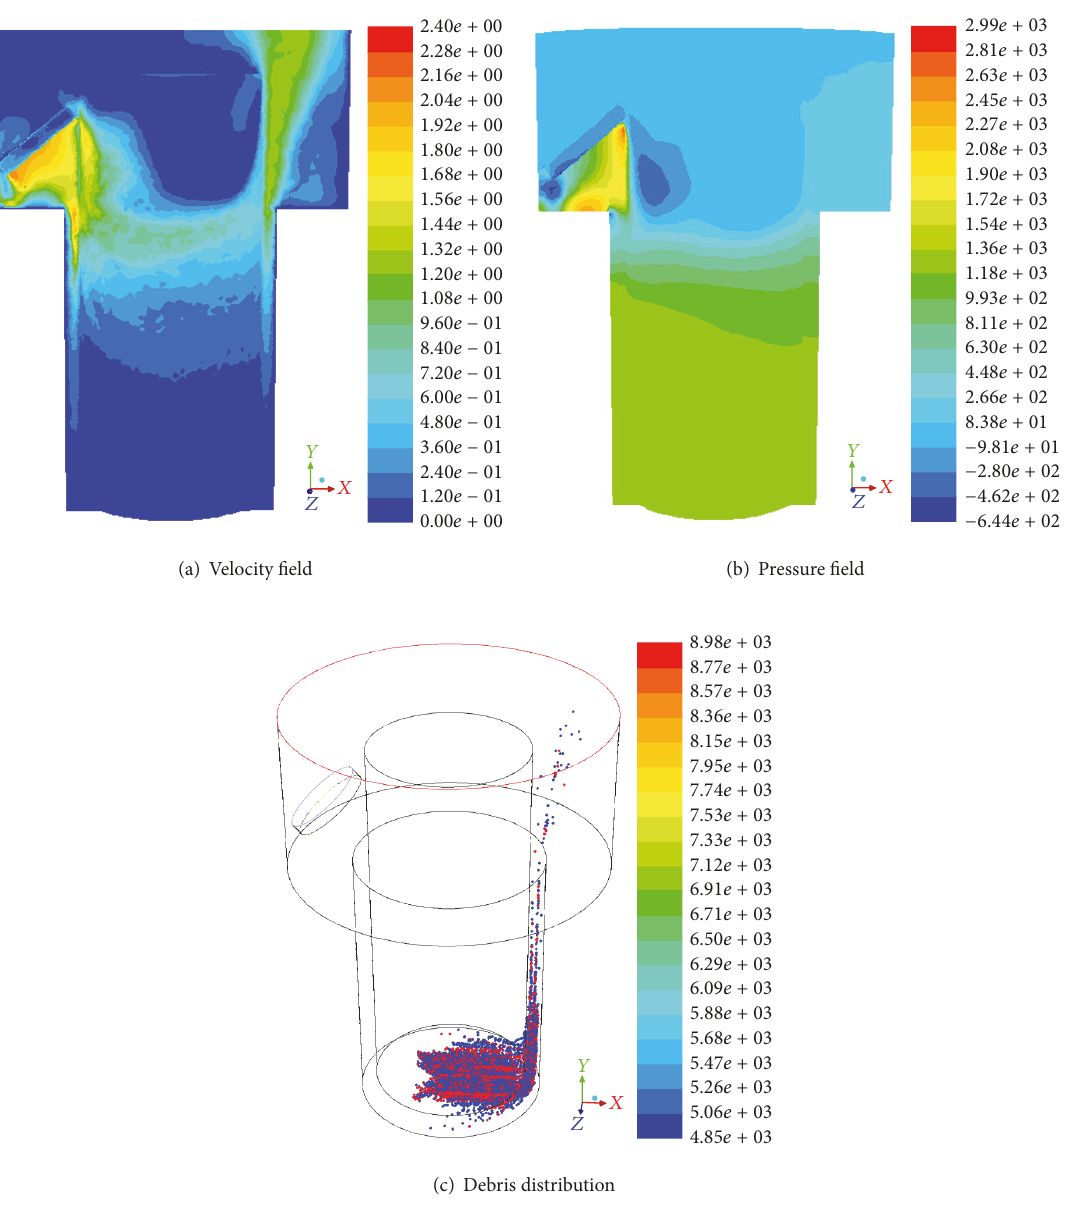
Figure 16: Schematics of gap flow field with flushing at 2m/s and 3.5 mm deep